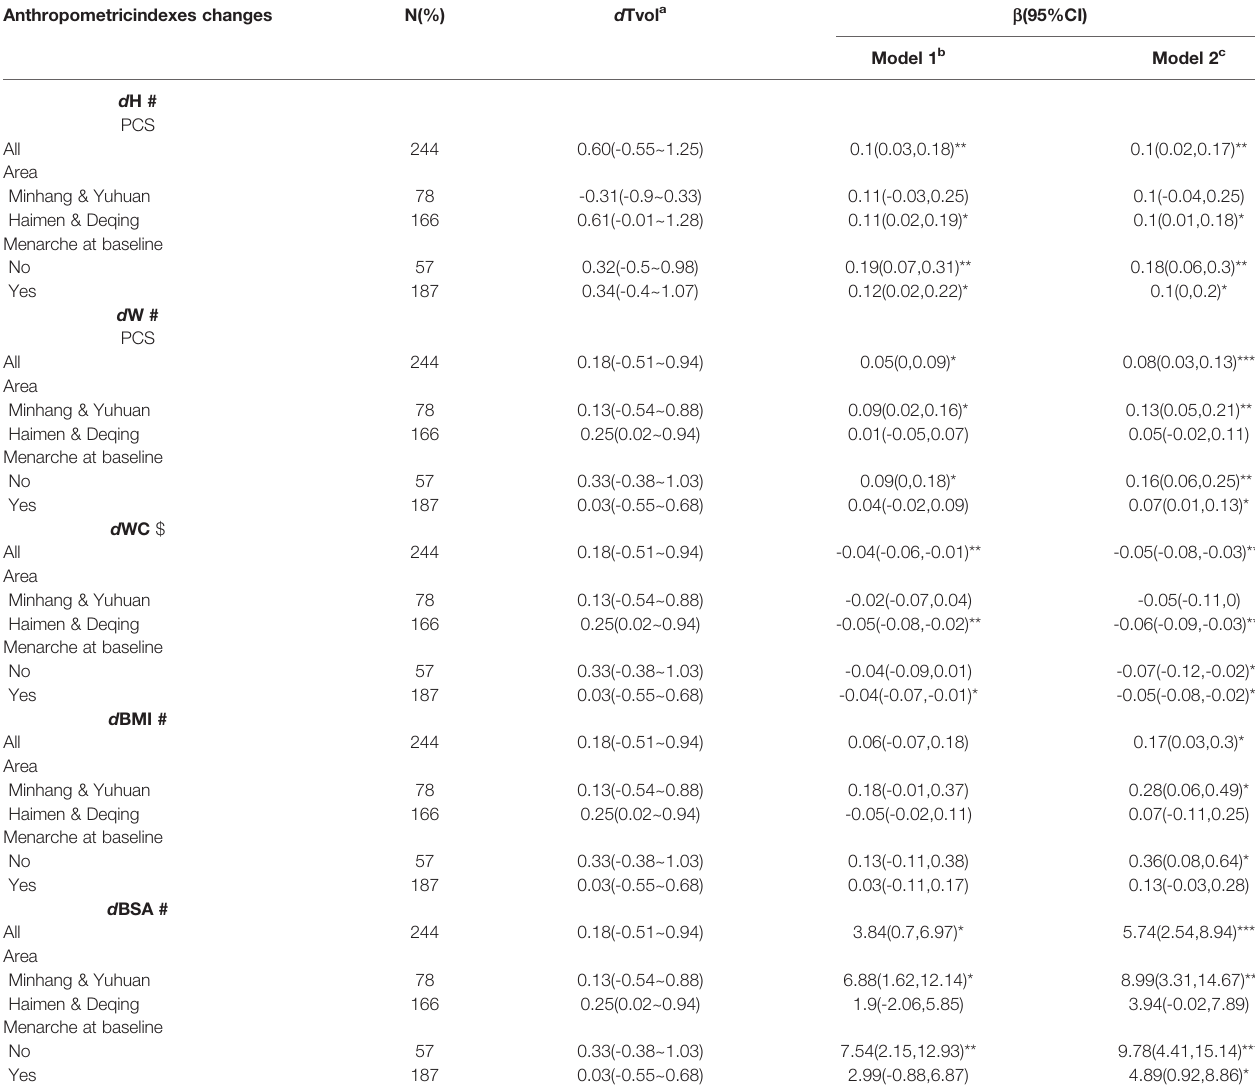
TABLE 3 | Regression coef fi cients ( b s) and 95% con fi dence intervals (95% CIs) for Tvol changes with anthropometric indexes changes by multiple linear regression models in 13 to 14-year-old group. Anthropometricindexes